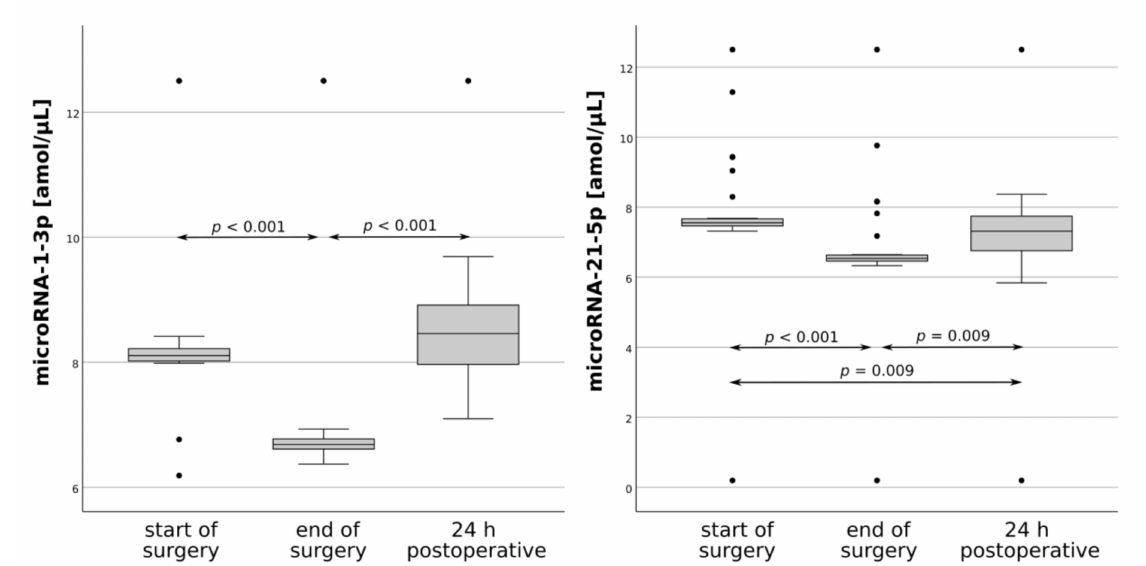
Figure 1. Time course of microRNA-1-3p and microRNA-21-5p plasma levels. The lower boundary of the box indicates the 25th percentile; the upper boundary of the box indicates the 75th percentile; the line within the box marks the median. Whiskers indicate 10th and 90th percentiles, and dots represent outliers.